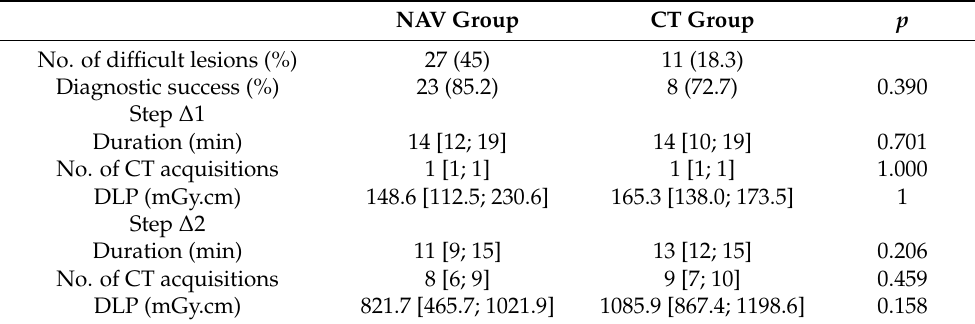
Table 4. Outcomes for “difficult” lesions in terms of diagnostic success, procedure duration, number of CT acquisitions and radiation